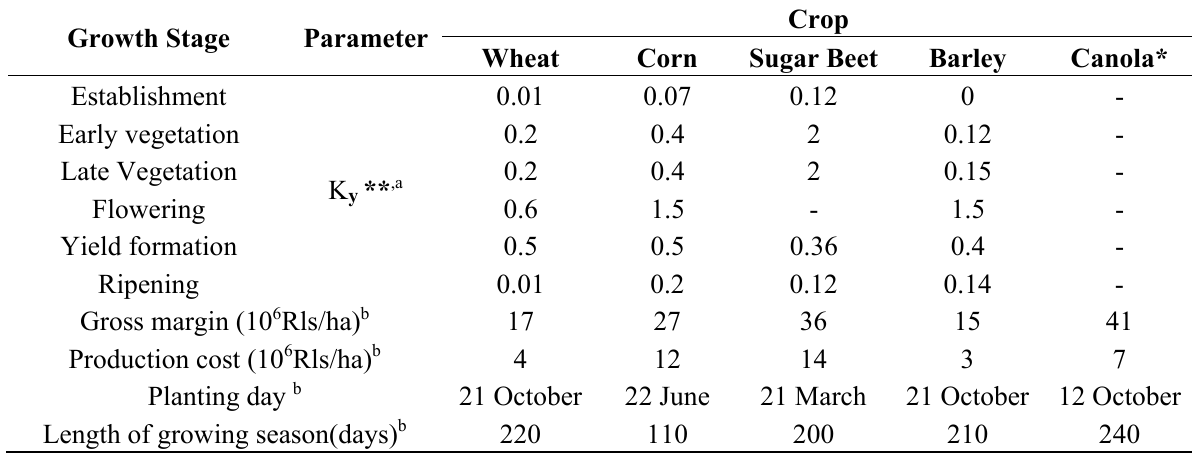
Table 1. Some critical data for the indicated crops in study